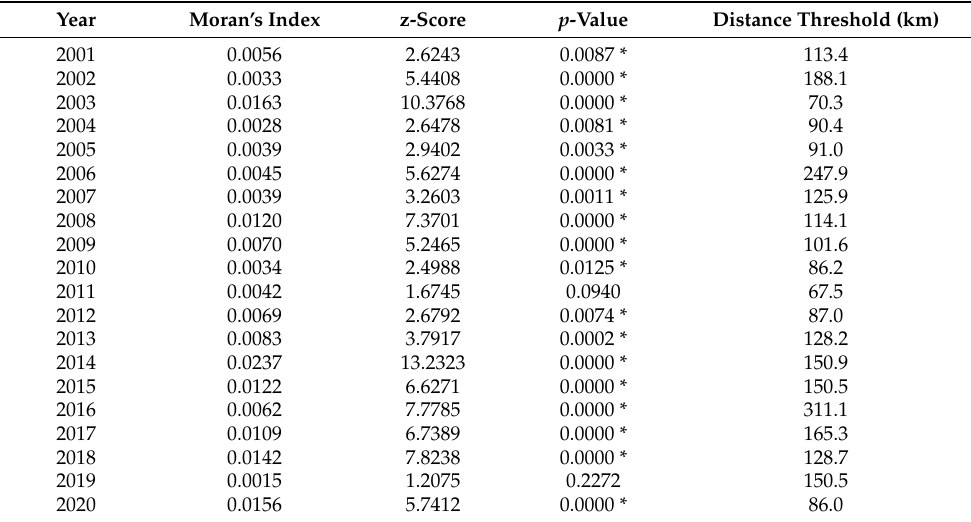
Figure 6. Area burned annually in the period 2001–2020 in the KBAs and in the rest of the national territory. Table 2. Global Moran’s I index of Bolivia’s burned areas during 2001–2020. Significance ( p < 0.05) is represented by an asterisk.